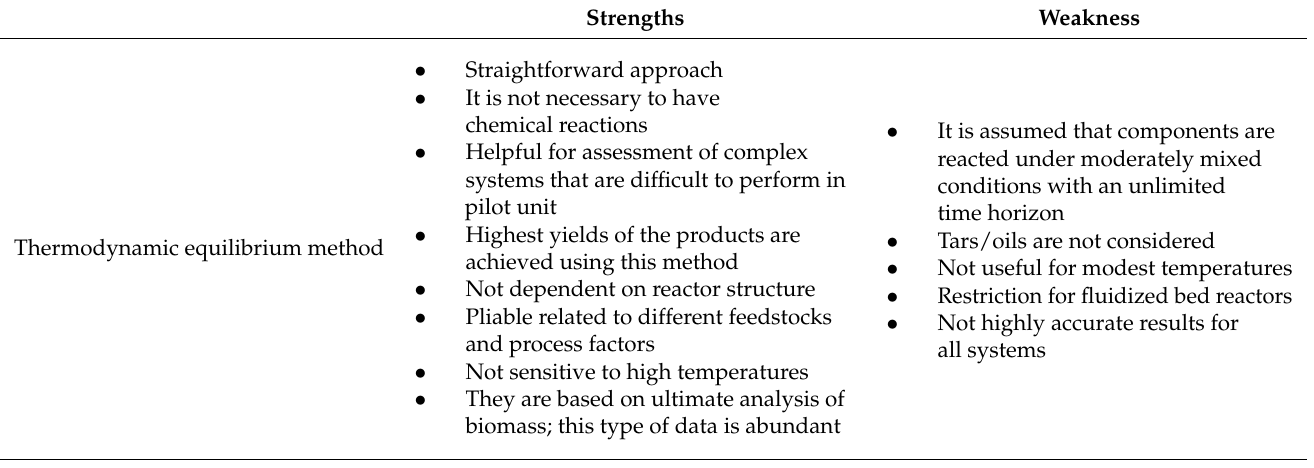
Table 1. Features and weakness of pyrolysis modeling